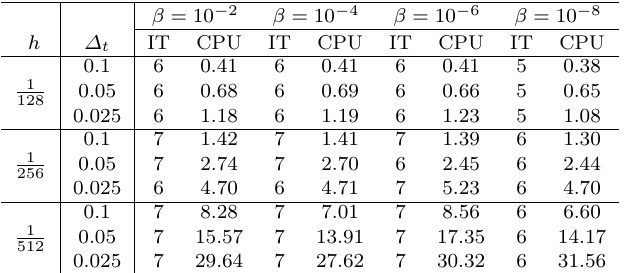
Table 3. Problem 1: Performance of the midpoint trapezoidal method ( N = 5)